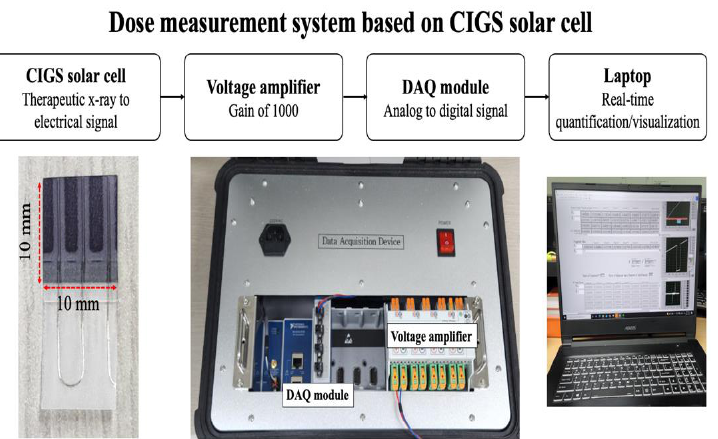
Figure 2. Configuration and data acquisition process of our measurement system based on a copper indium gallium selenide (CIGS) solar cell. In this system, therapeutic X-ray radiation is converted to electrical signals by the CIGS solar cell, and the electrical signals were digitalized through data acquisition (DAQ) module. The digitalized signals were visualized in real-time using a laptop with in-house software.